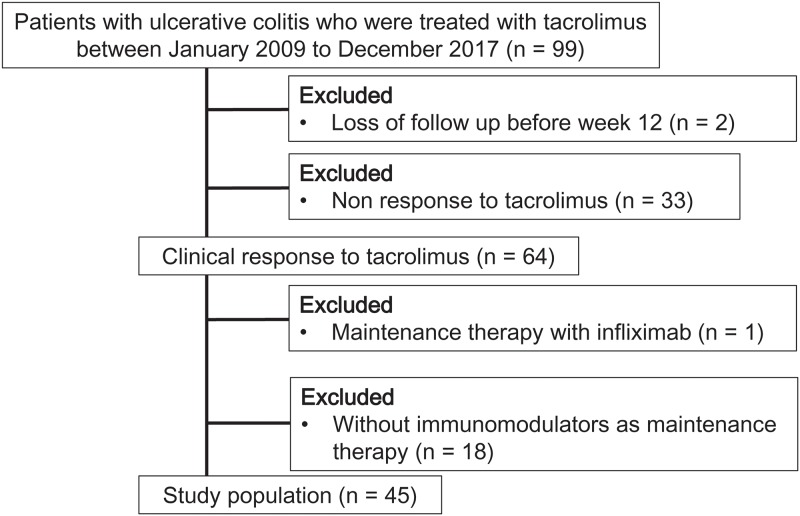
Details of study selection.